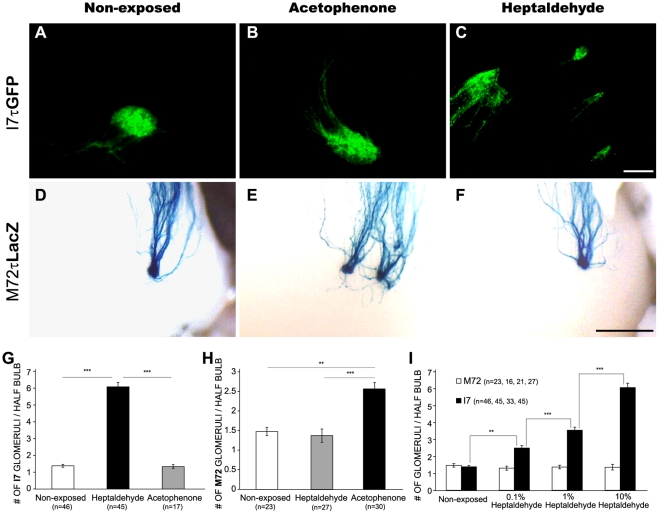
Chronic odorant exposure led to the dose-dependent and circuit-specific formation of supernumerary glomeruli.Figures A–C show representative I7tauGFP glomeruli from non-exposed mice and from those exposed to pure acetophenone and 10% heptaldehyde, the latter being the cognate ligand. Figures D–F show representative M72tauLacZ glomeruli from non-exposed mice and from those exposed to pure acetophenone and 10% heptaldehyde, the former being the cognate ligand. Scale bar 100 µm (I7tauGFP) and 500 µm (M72tauLacZ). The bar graphs in G and H show the average number of I7 and M72 glomeruli per half bulb, respectively, for each condition. The bar graph in I depicts the average number of I7 and M72 glomeruli in response to different concentrations of heptaldehyde. Kruskal-Wallis sum rank test: p<0.01 followed by Dunn multiple comparison test: **, P<0.01; ***, P<0.001.